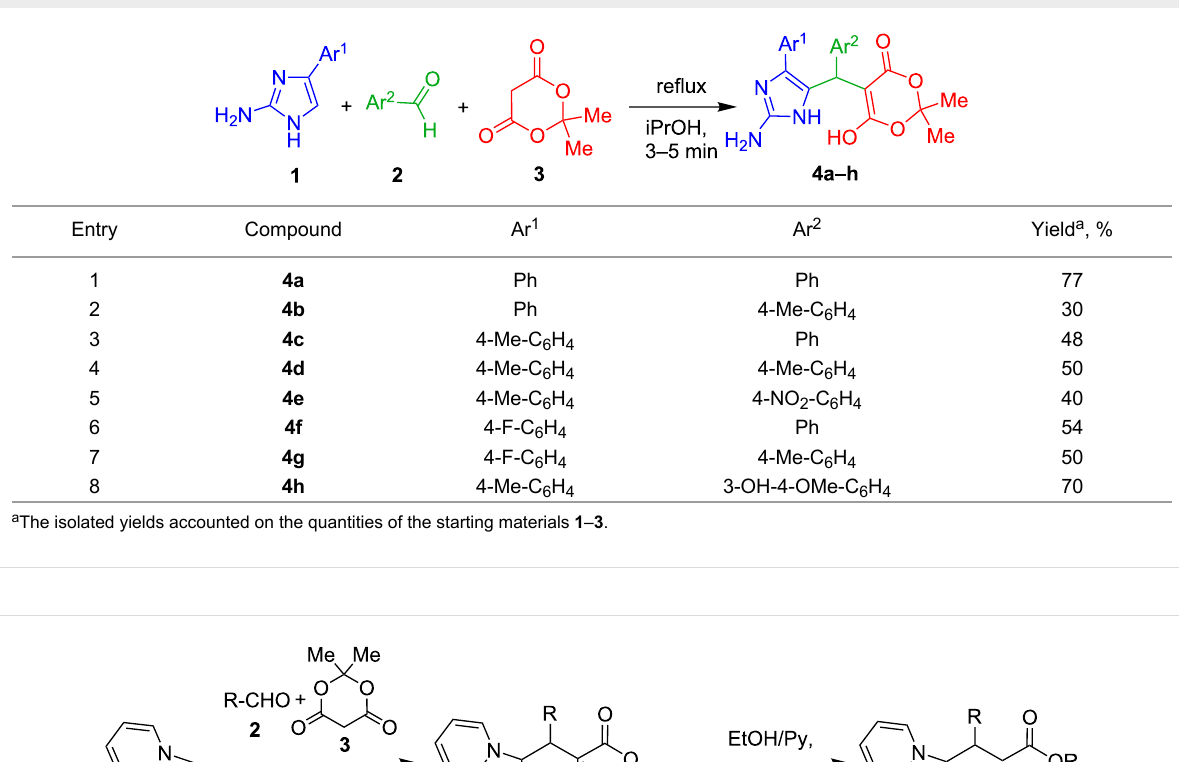
Table 1: Three-component condensation of 2-amino-4-arylimidazoles, aldehydes and Meldrum’s